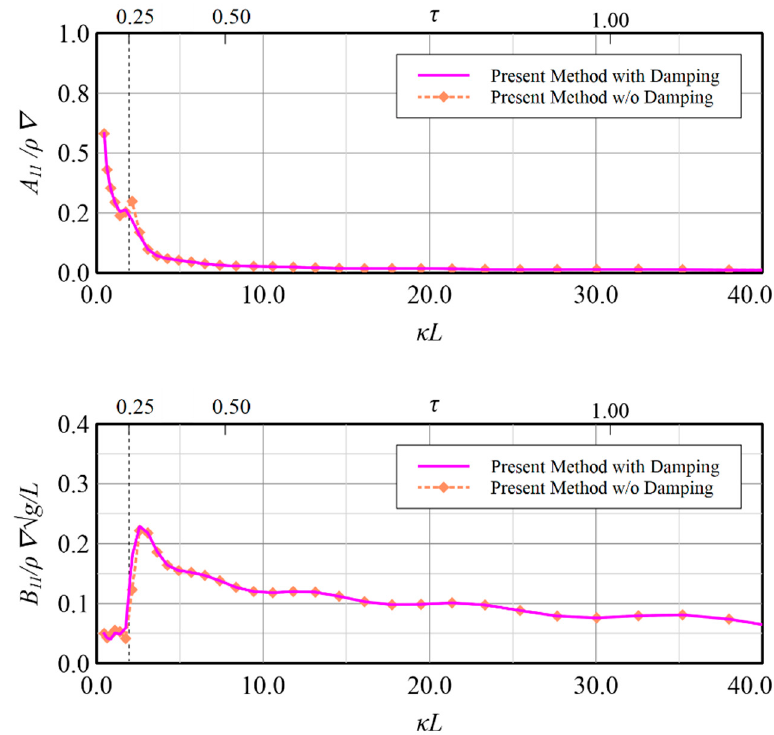
Figure 19. Surge-induced-surge added mass and damping coefficient at F r = 0.18.